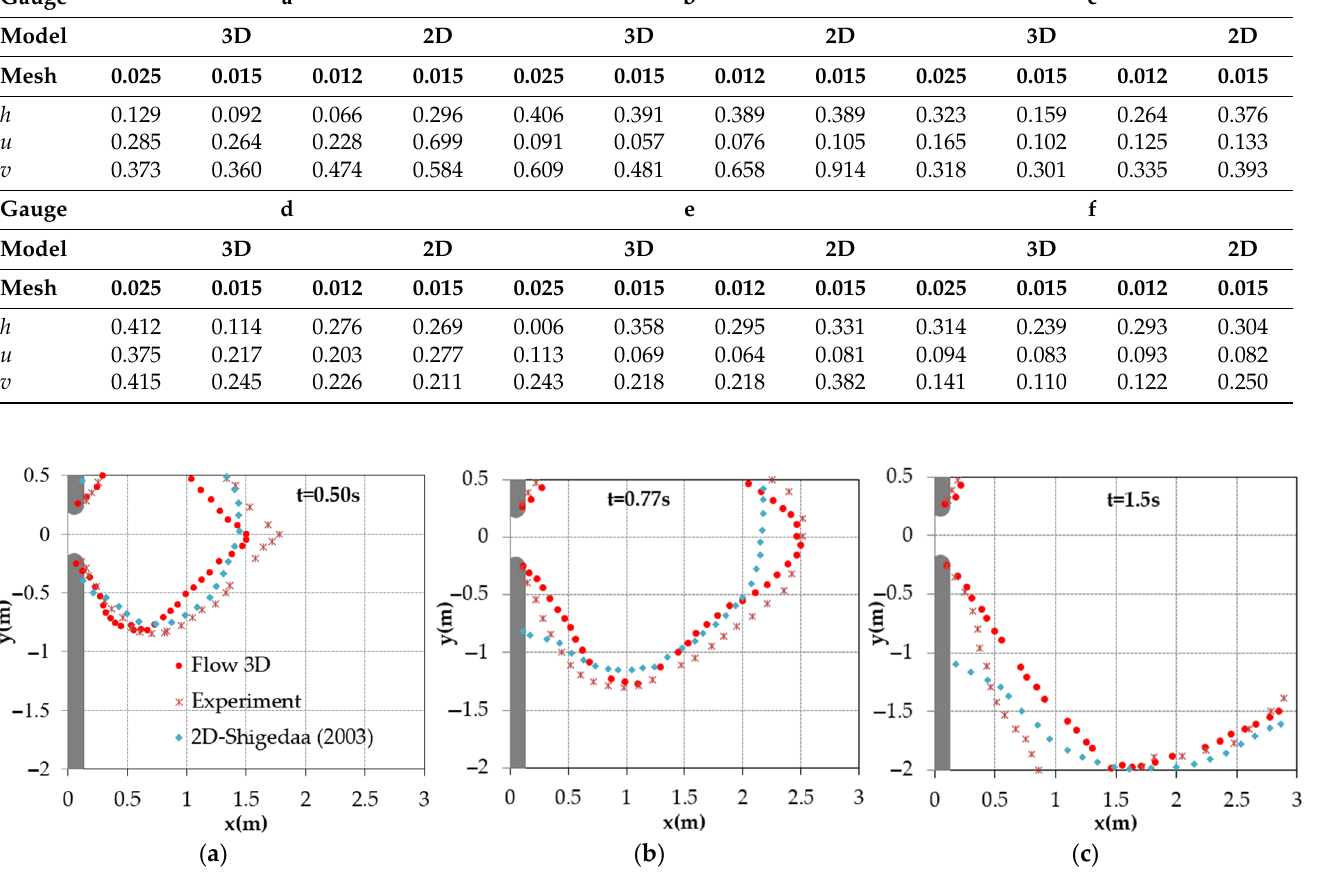
Figure 3. Flood extent at downstream. ( a ) t = 0.50 s, ( b ) t = 0.77 s, ( c ) t = 1.50 s. With the aforementioned test case, the presented numerical model and optimal mesh cell size of 0.015 m can be used to accurately characterize dynamics and structure